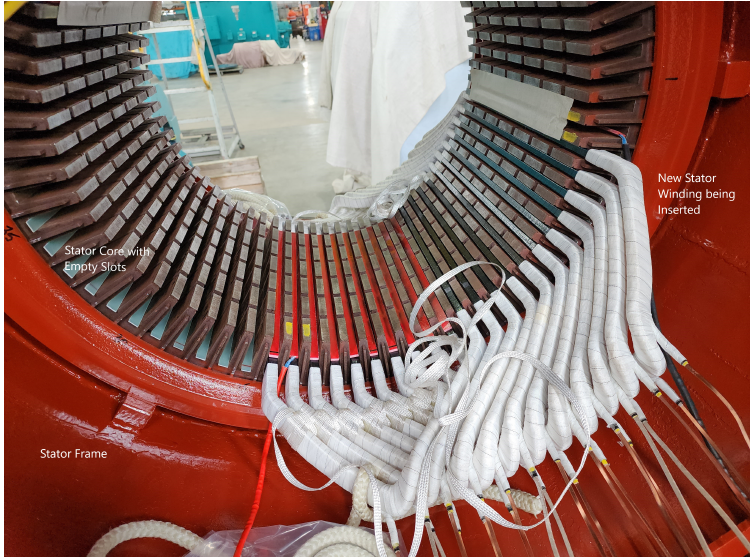
Figure 6. Motor stator core with